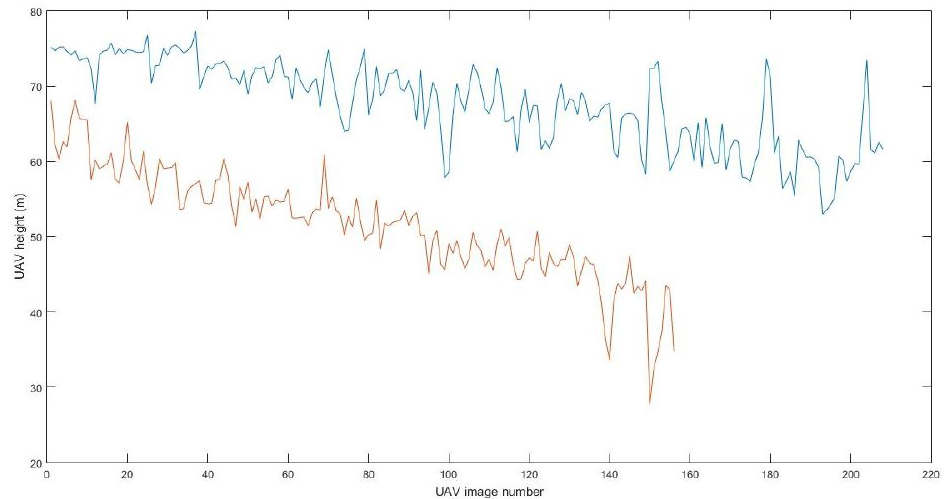
Figure 11. UAV flight heights above the NDTM using NDTM in mission planning (blue) and using plane DEM in mission planning (red).